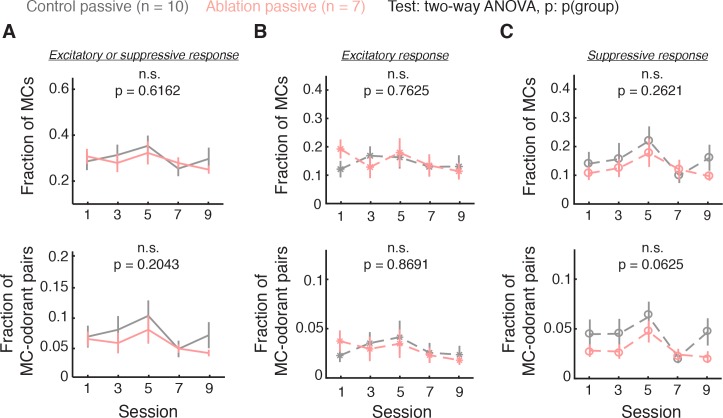
Task engagement enhances MC suppressive responses through ABNs.(A–C) Fraction of responsive MCs (top) and responsive MC-odorant pairs (bottom) during passive exposure. Control passive: n = 10; ablation passive: n = 7. Mean ±S.E.M. (A) MCs with either excitatory or suppressive responses. Fraction of MCs: p=0.6162; fraction of MC-odorant pairs: p=0.2043. (B) MCs with excitatory responses. Fraction of MCs: p=0.7625; fraction of MC-odorant pairs: p=0.8691. (C) MCs with suppressive responses. Fraction of MCs: p=0.2620; fraction of MC-odorant pairs: p=0.0625. All p values are for two-way ANOVA, control passive vs. ablation passive.